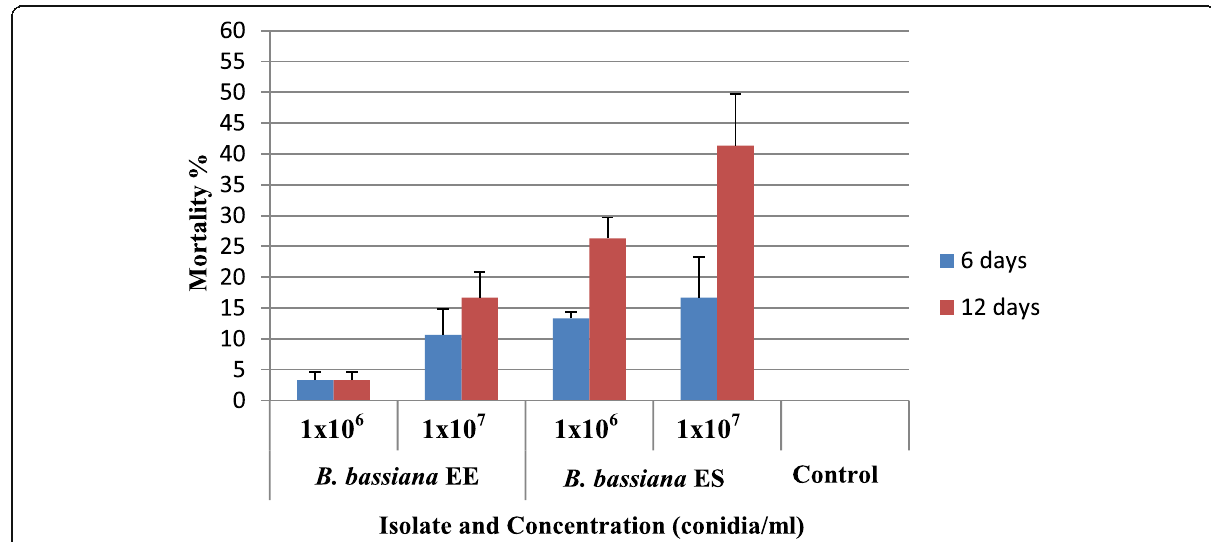
Fig. 2 Pathogenicity of both Beauveria bassiana isolates to squash beetle Epilachna chrysomelina adults under laboratory